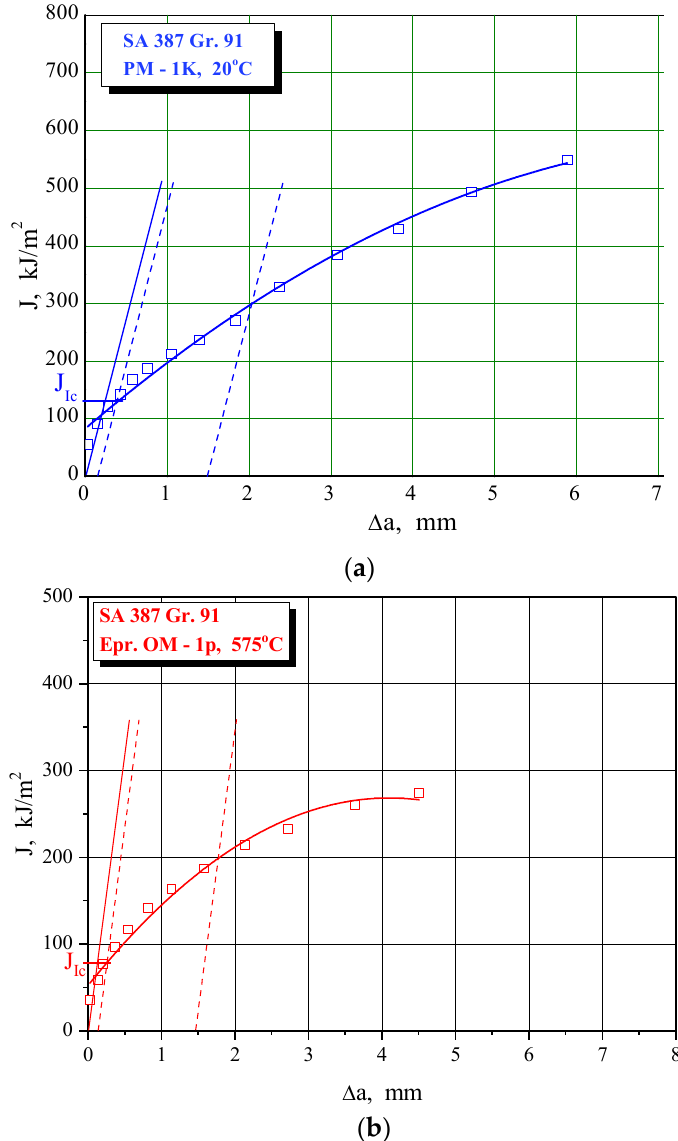
Figure 11. The J ‐ R curve and J Ic evaluation for SA 387 Gr. 9—BM at ( a ) 20 °C, ( b ) 575 °C. Figure 11. The J-R curve and J